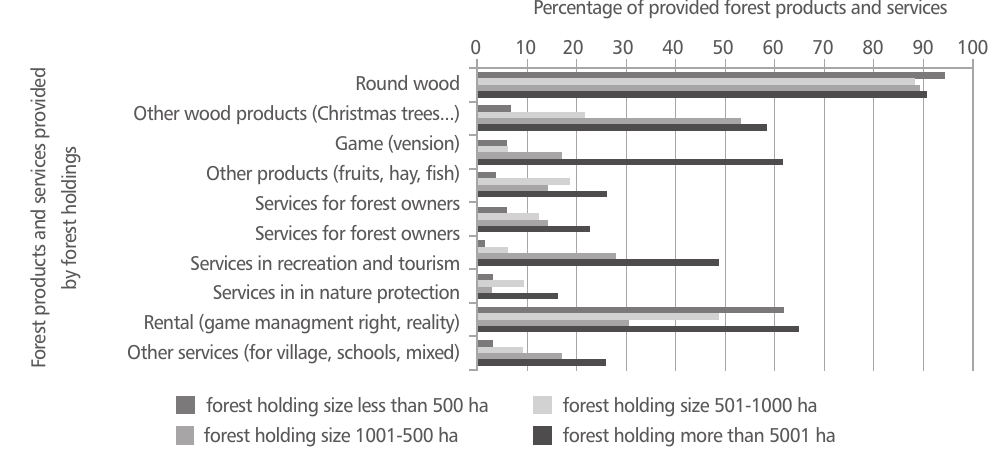
FIGURE 1. The product mix in Slovakia